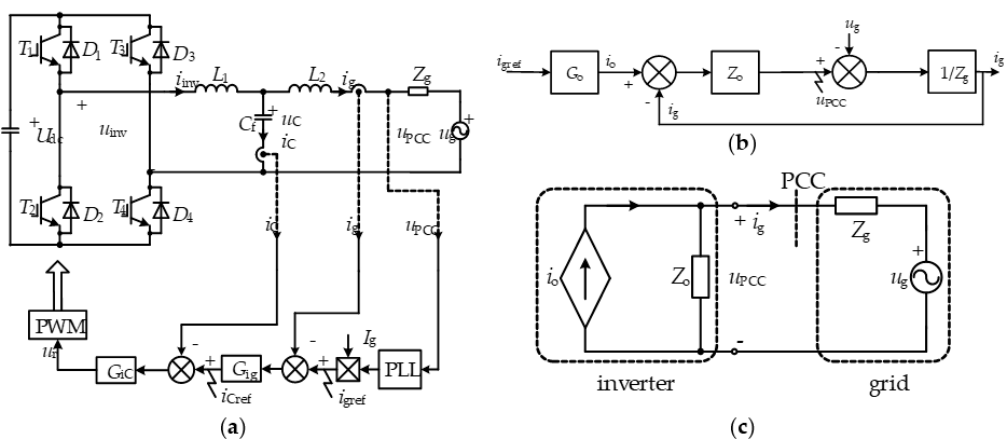
Figure 1. LCL (Inductor-Capacitor-Inductor)-type grid-tied inverter for single phase: ( a ) structure of main circuit; ( b ) structure of impedance model; ( c ) structure of equivalent circuit model.